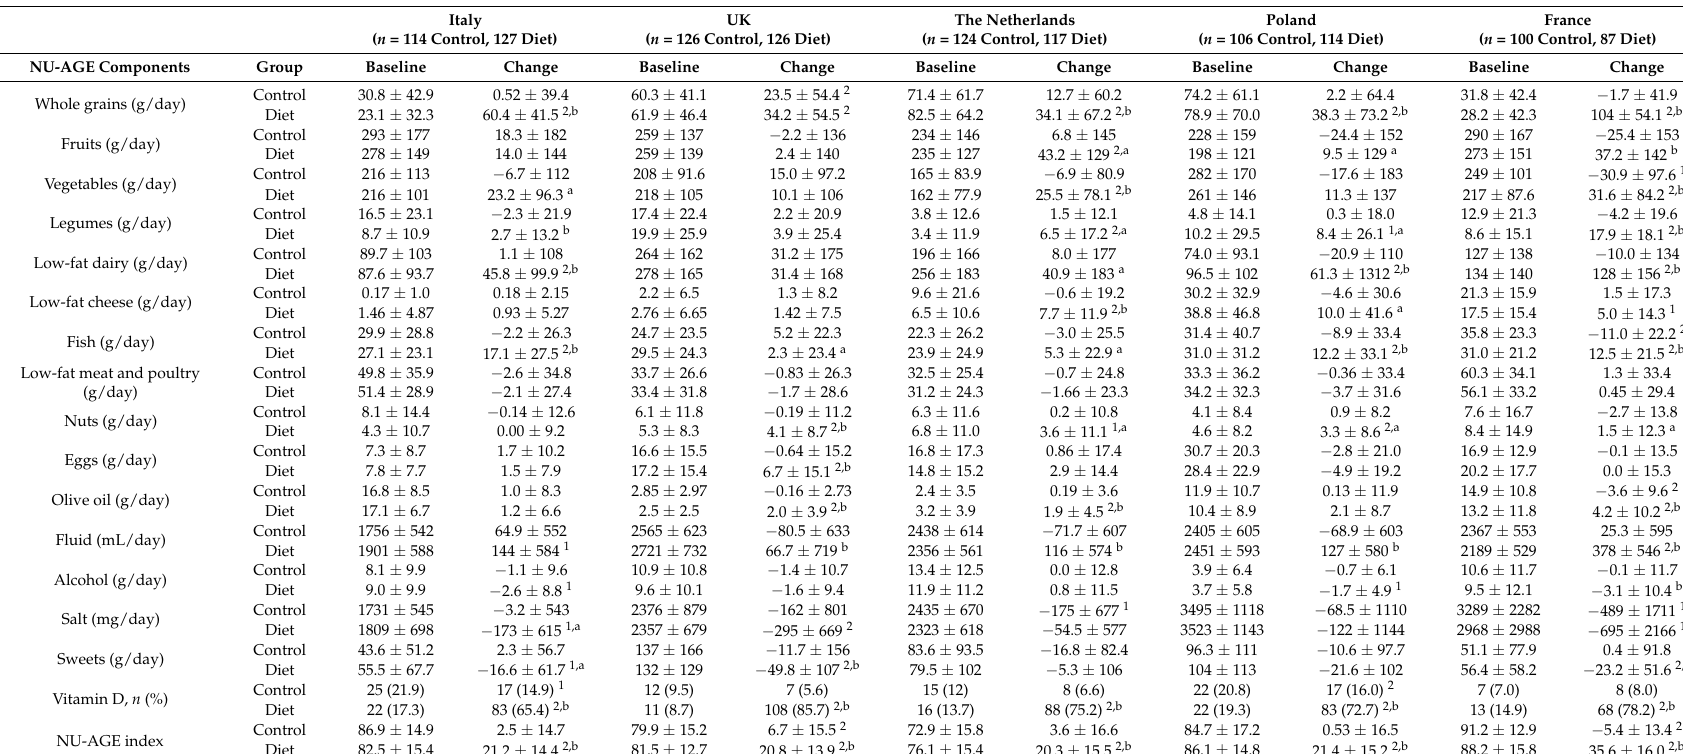
Table 4. Mean baseline and changes in dietary intake (g/day) of NU-AGE diet components by intervention group stratified by study center ( n = 1141).